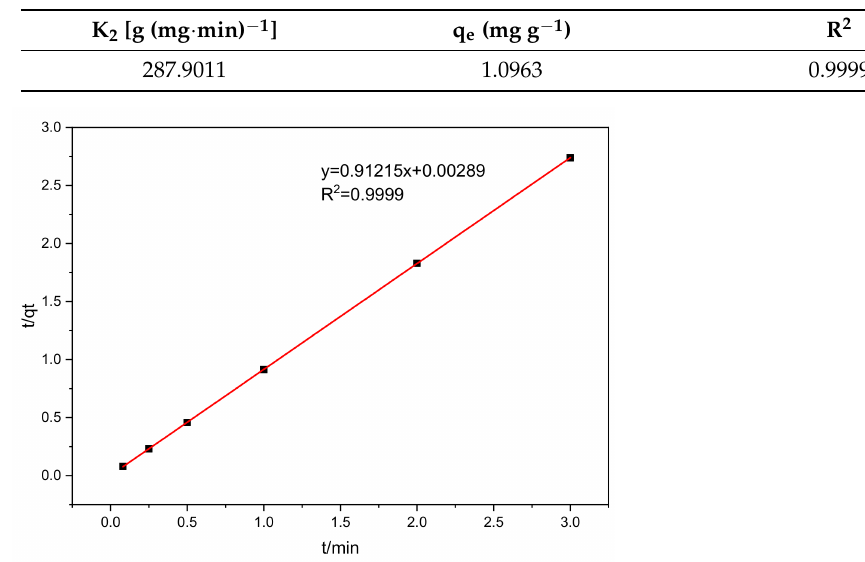
Table 1. Parameters of pseudo second order kinetic model.